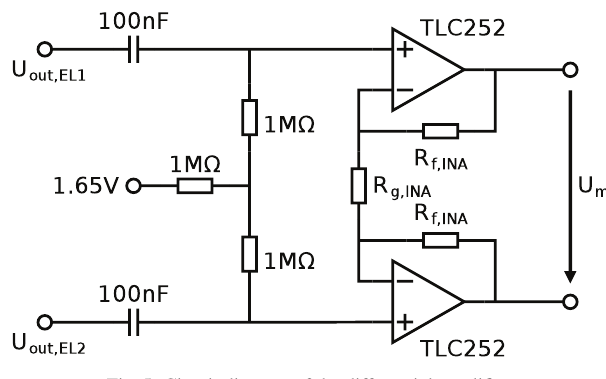
Fig.5: Circuit diagram of the differential amplifier.